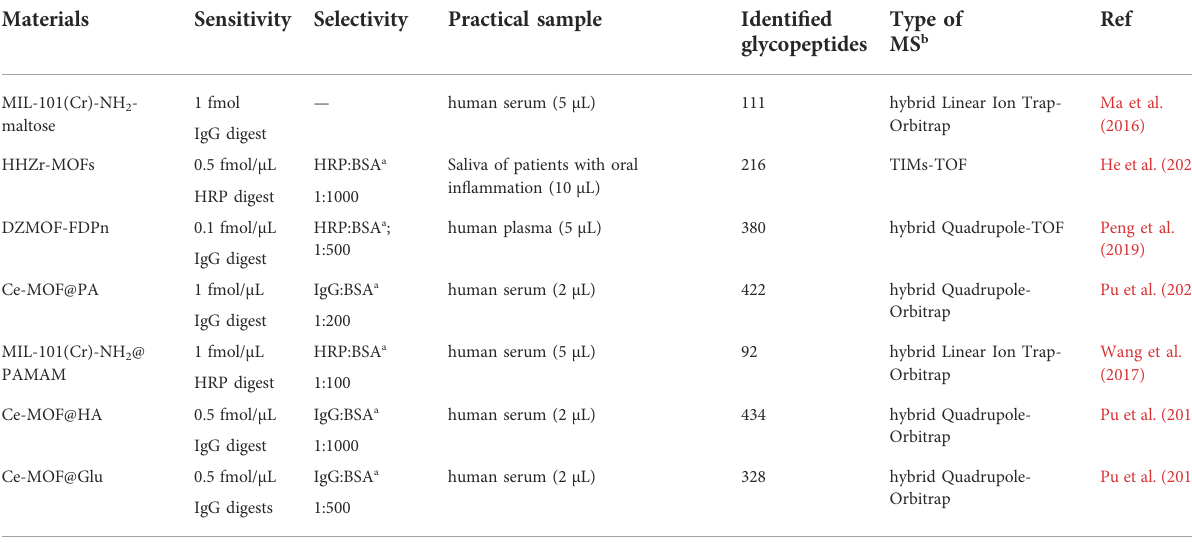
TABLE 2 Representative display of MOFs with chemical modi fi cations in glycoproteomics. Materials